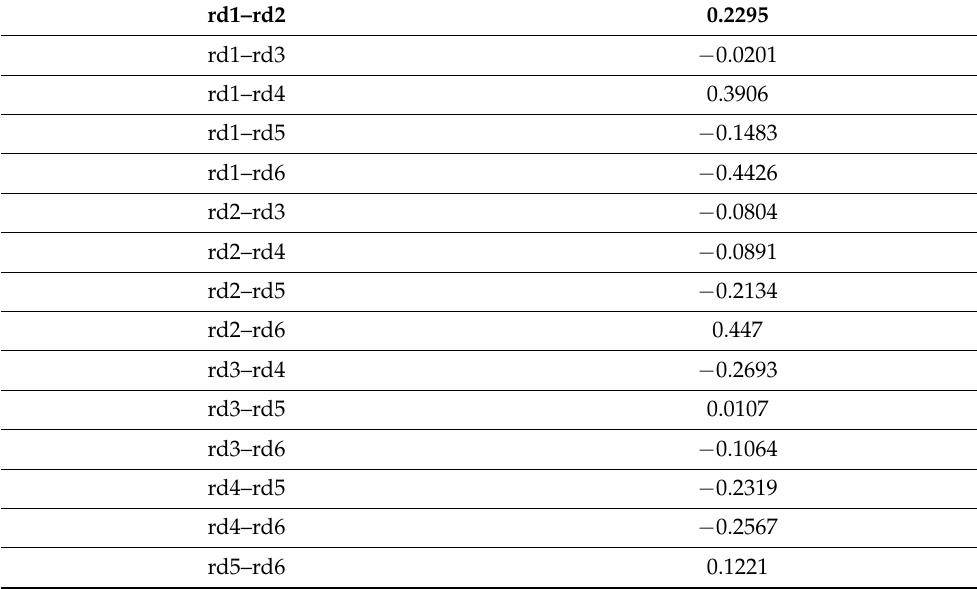
Table 8. Pearson correlation coefficients between the 6 weight regimes.